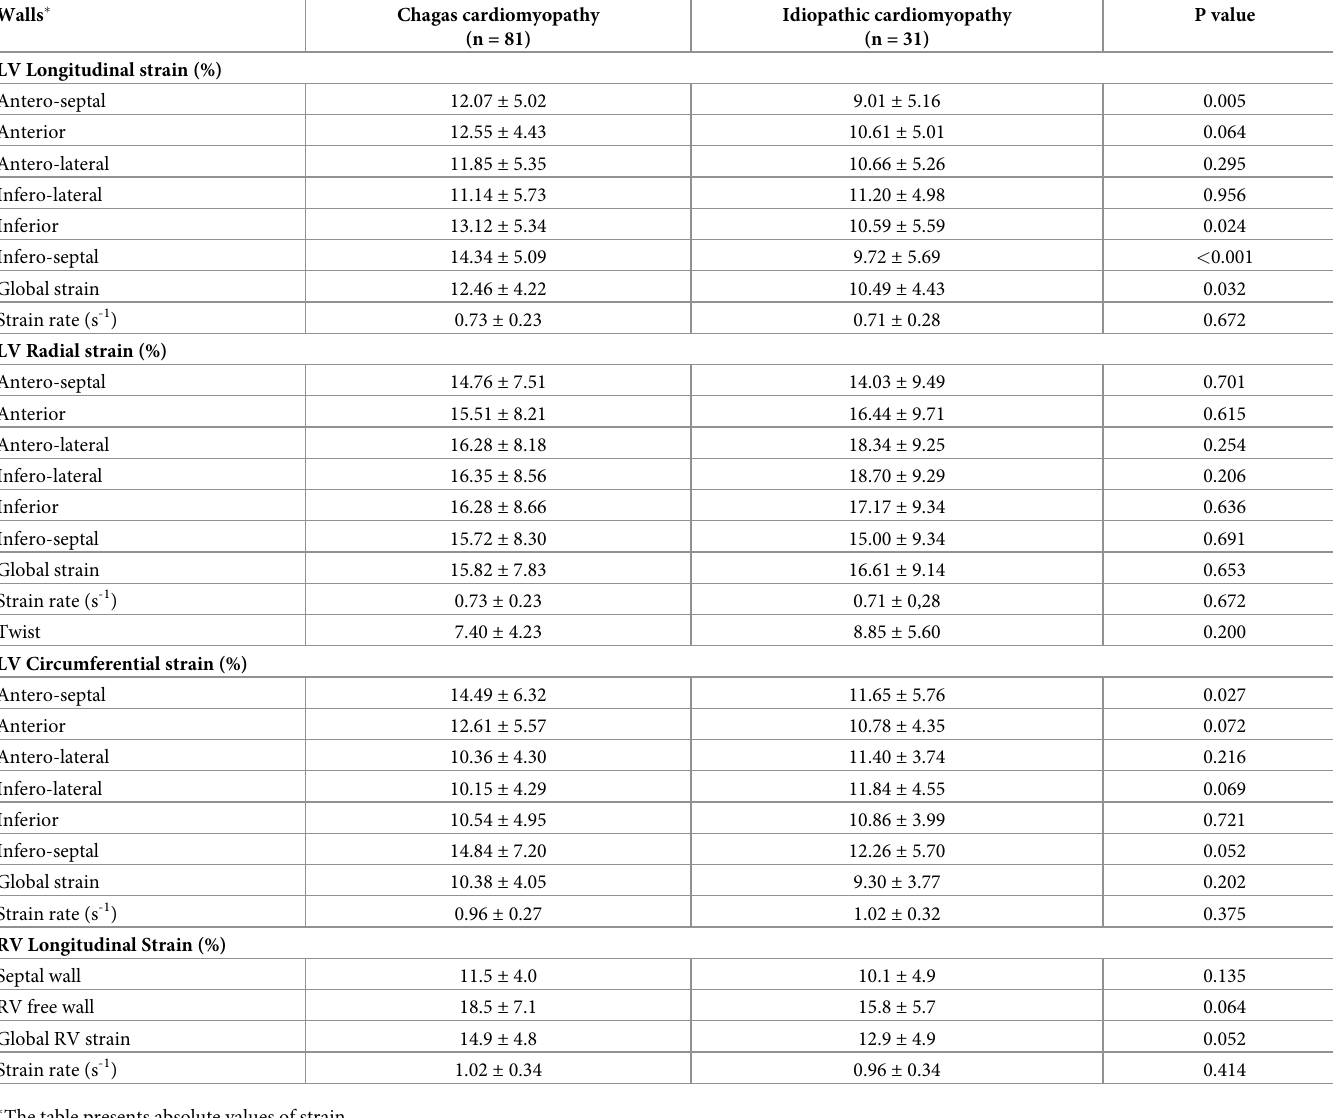
Table 2. Ventricular speckle tracking strain of patients with Chagas cardiomyopathy compared to idiopathic